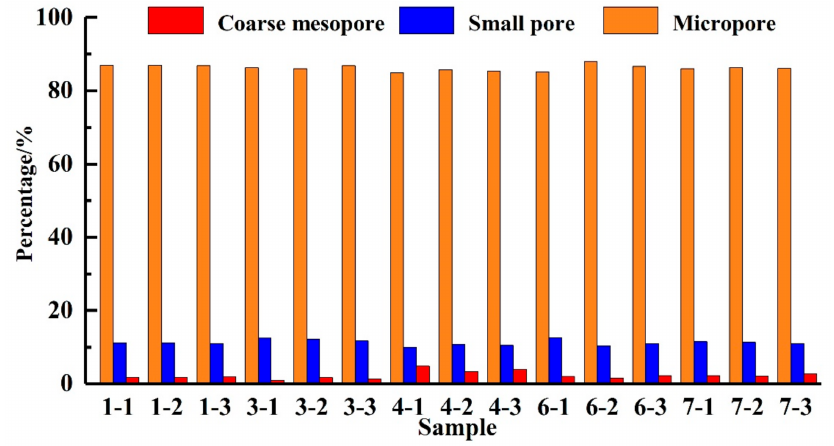
Figure 8. The percentages of different pore